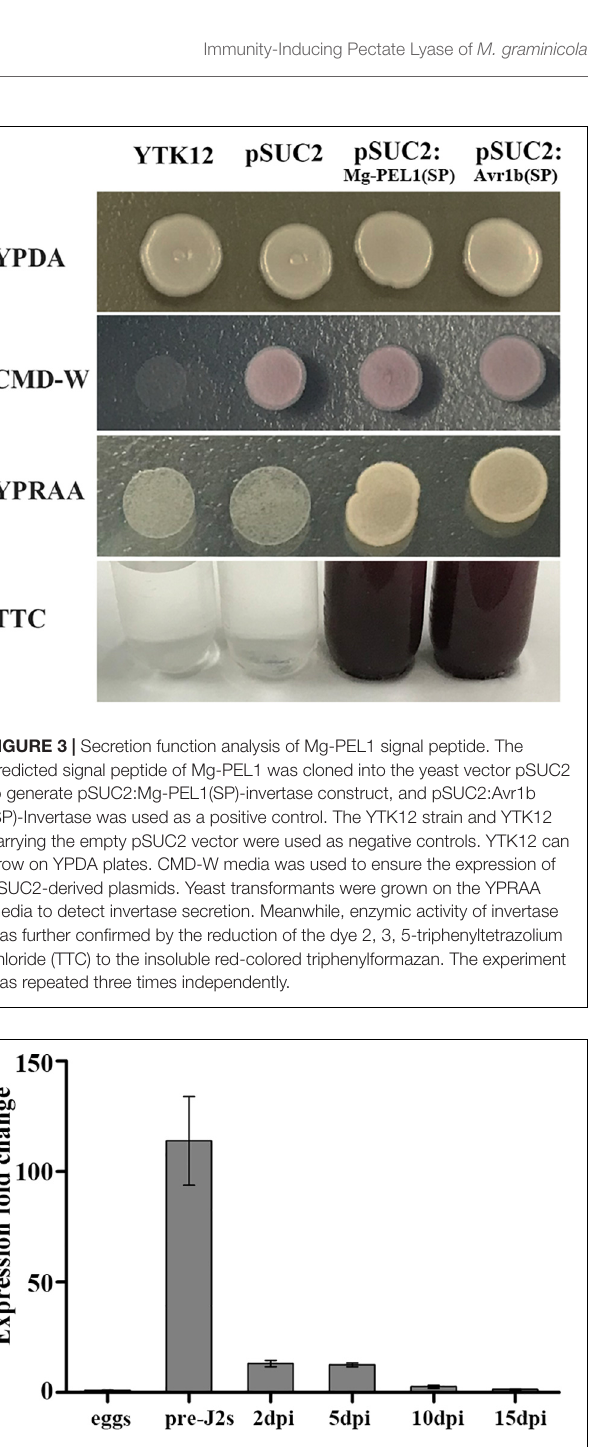
FIGURE 4 | Expression of Mg-PEL1 in Meloidogyne graminicola at different life stages. The fold change values were presented as the change in expression relative to the egg. Data shown are the means of three repeats plus standard deviation ( ± SD). Three independent experiments were performed with similar results. dpi, day post-infection; pre-J2s, pre-parasitic second-stage juveniles.